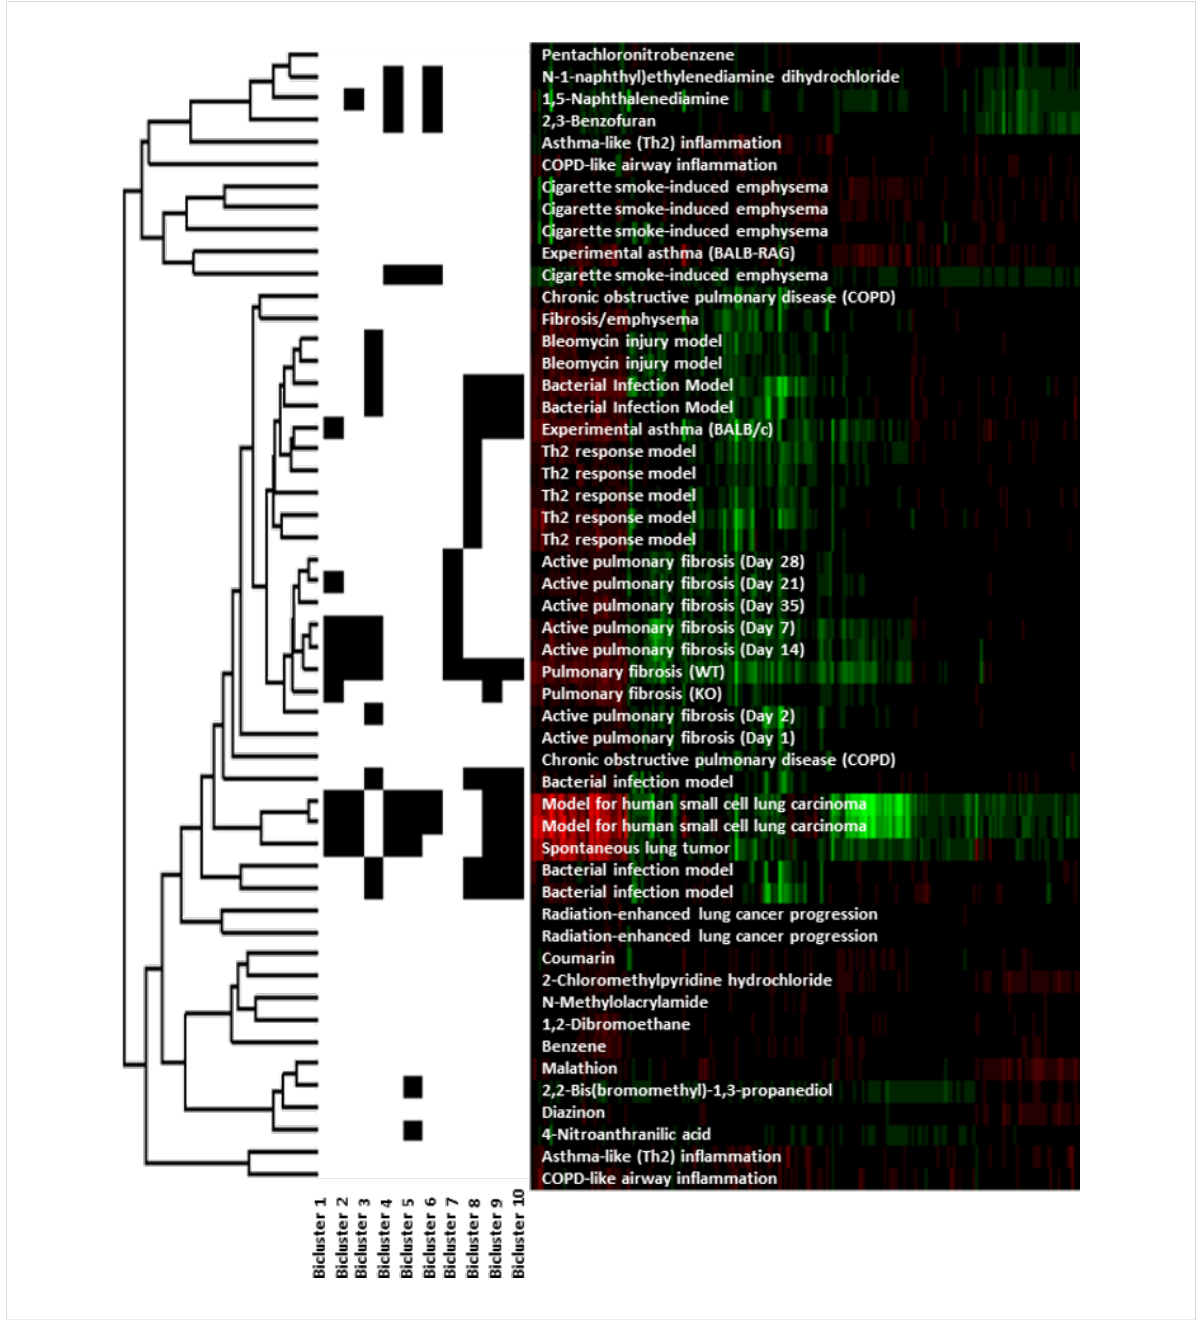
Figure 1: Heatmap of the gene symbols obtained from the bicluster data analysis. The distance metric used for the cluster analysis was 1-correlation estimated using Spearman correlation with average linkage.